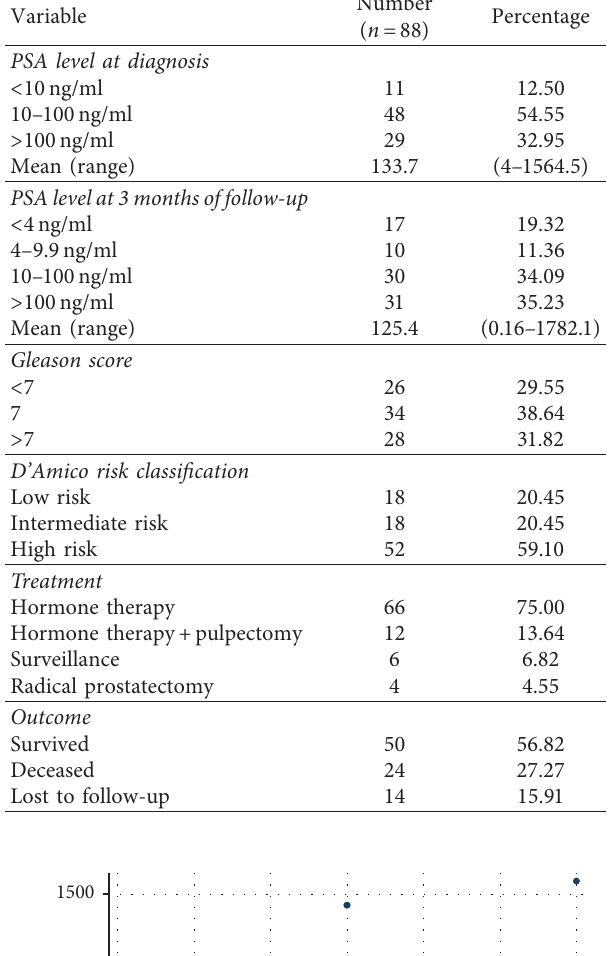
Table 2: PSA level, prognostic features, and different treatment approaches of the patients.